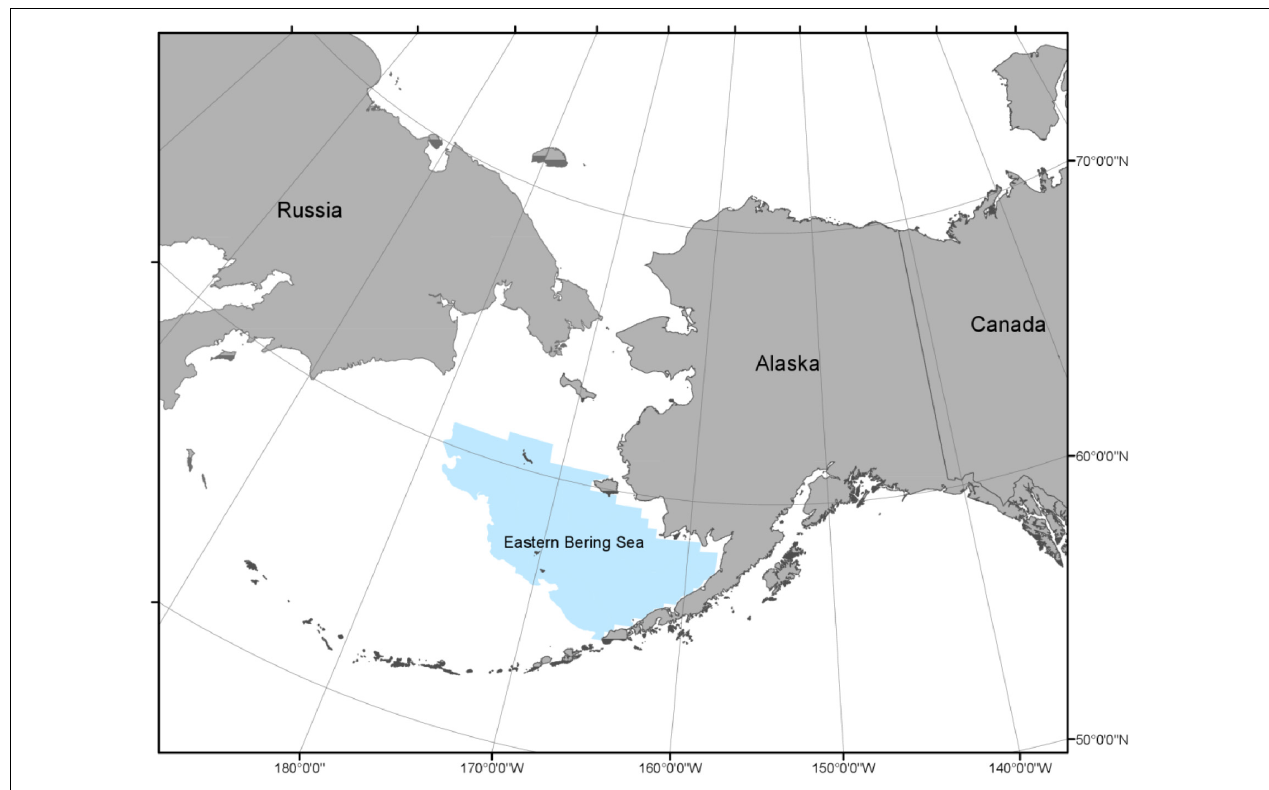
FIGURE 2 | The area in the eastern Bering Sea described by the EwE model of Aydin et al. (2007).